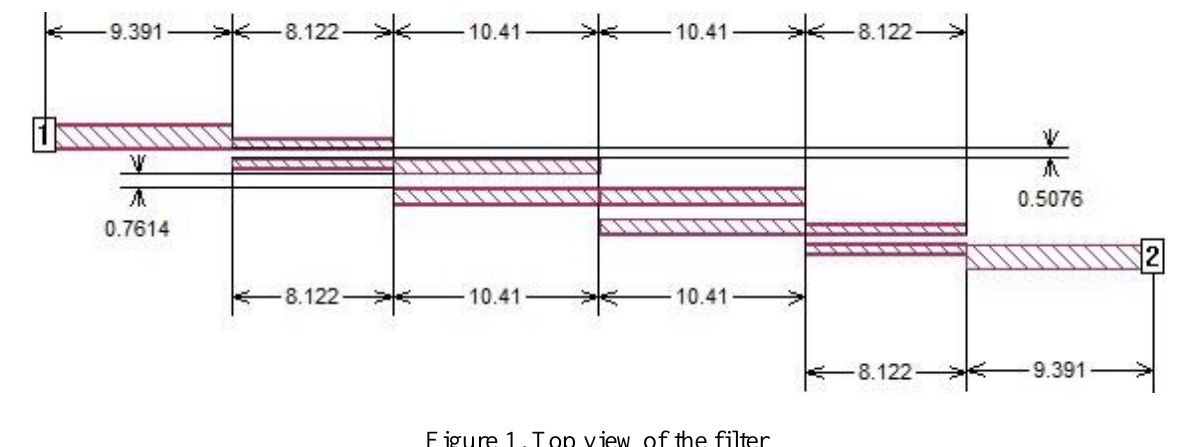
Figure 1. Top view of the filter